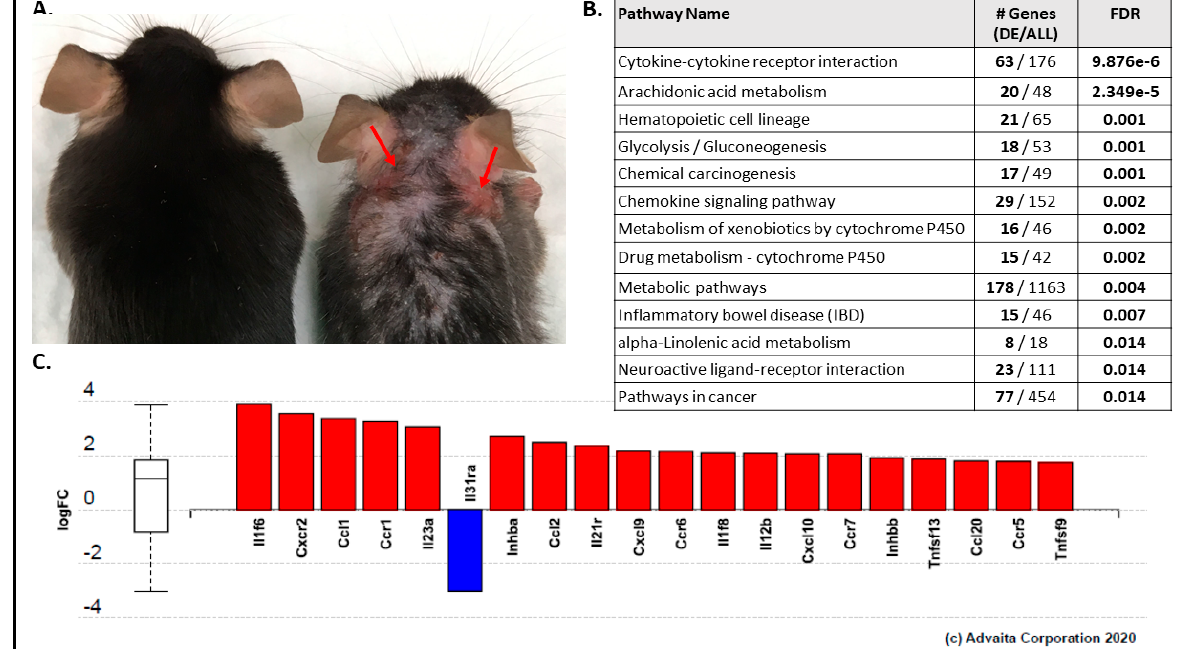
Figure 2. C57. Pparg -/- epi mice exhibit alopecia and cutaneous lesions while the top KEGG pathway that maps to the differential expression analysis is associated with inflammatory signaling. ( A ) Representative photograph of a C57. Pparg -/- epi mouse (right) and a wildtype littermate (left). Areas of erythematous skin lesions that develop spontaneously in these mice are noted by the red arrows. Alopecia and skin flaking are also observed. ( B ) Differentially expressed genes were mapped to KEGG pathways using iPathwayGuide (Advaita Corporation. Thirteen KEGG pathways mapped to our data set with an FDR < 0.05. ( C ) The top 20 of 63 genes that mapped to the cytokine-cytokine receptor interaction KEGG pathway (iPathwayGuide, Advaita, KEGG:04060) are shown. Gene mapping was restricted to genes that had a |log2 FC| ≥ 0.6 at an FDR < 0.05. Up-regulated genes are shown in red columns and down-regulated genes are shown with blue columns. The Y -axis represents the log2 fold change (logFC).